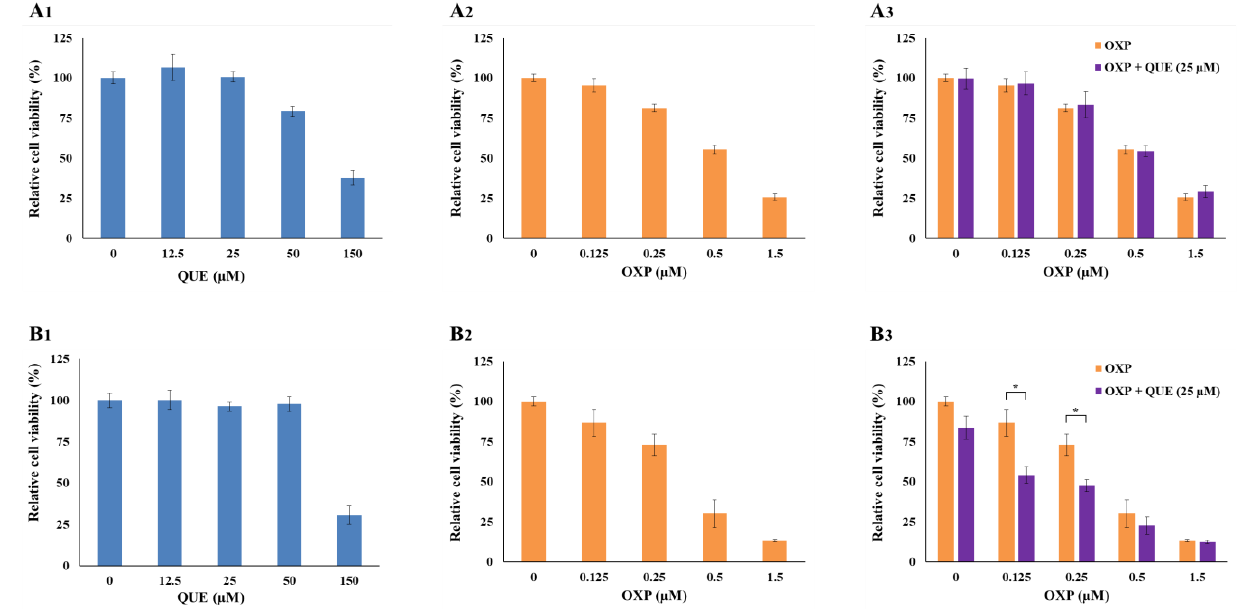
Figure 2. QUE enhanced OXP-mediated suppression of HCT116 cell proliferation. HCT116 cells were plated in a 96-well plate and treated with QUE, OXP, or their combination for 3 days ( A 1 –A 3 ) and 6 days ( B 1 –B 3 ). QUE at ≤ 50 μM for 6 days did not influence cell viability. However, the viability of OXP-treated cells was significantly decreased in the presence of QUE at 25 μM. Error bars, mean ± SEM ( N = 3). Statistical significance was determined by Student’s unpaired t -test at p < 0.05, and indicated by an asterisk, *.